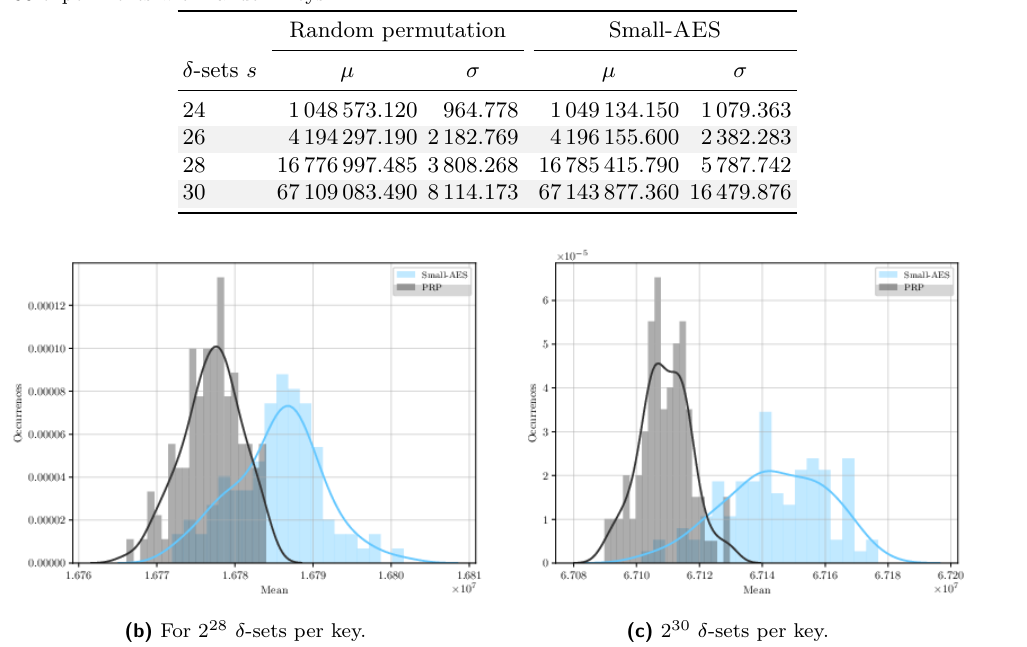
Figure 23: Results of the Heys-Liu experiments adapted to four rounds of Small- AES with 100 experiments with random